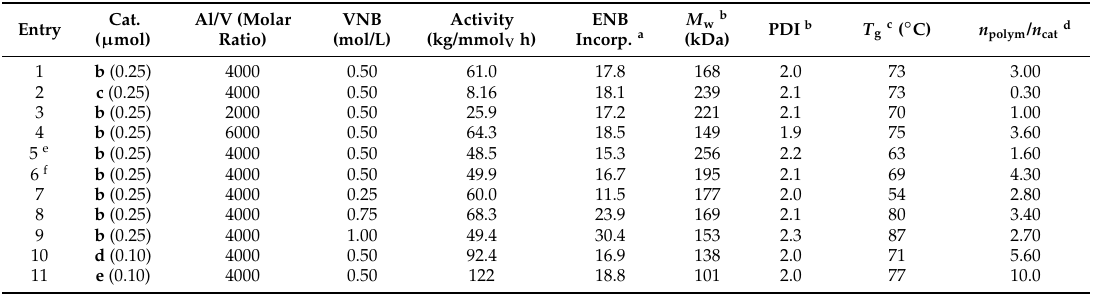
Table 2. Ethylene/ENB copolymerization by oxovanadium(V) complexes.